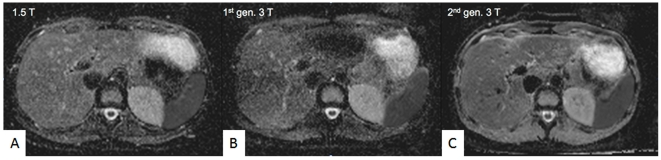
Representative source data from all three MR-scanners.Representative source data images taken from the 1.5 T MR scanner (A), the first generation 3 T MR-scanner (B) and the second-generation 3 T MR-scanner (C) show that the second-generation 3 T MR-scanner yields higher signal to noise ratio throughout all b-values which is particularly well appreciated at the higher b-values.